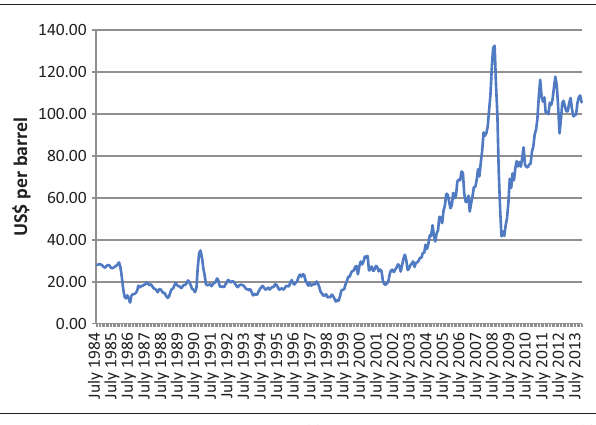
FIGURE 2: Monthly crude oil price – 30 year